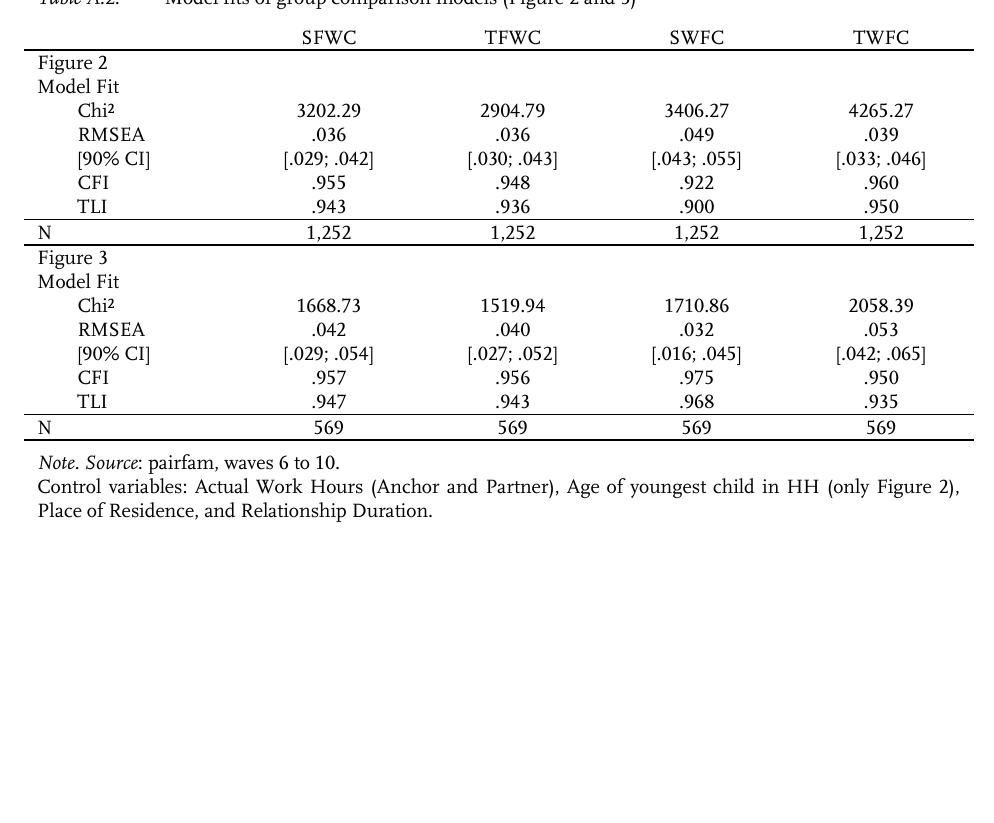
Model fits of group comparison models (Figure 2 and 3) Figure 2 Model Fit